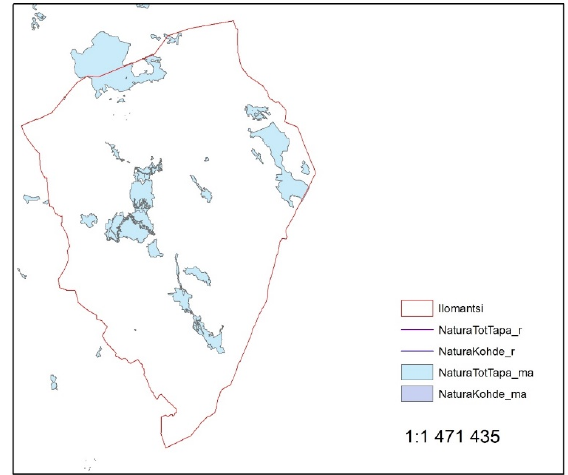
Figure 3. GIS layer of Natura 2000 areas in the Ilomantsi commune from the OIVA database.